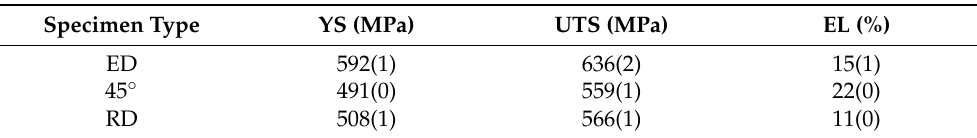
Figure 6. Stress–strain curves of the ED, 45°, RD specimens under quasi-static tension. Table 2. Quasi-static tensile properties of extruded 7075 Al alloy. (The numbers in the parentheses are standard deviations).